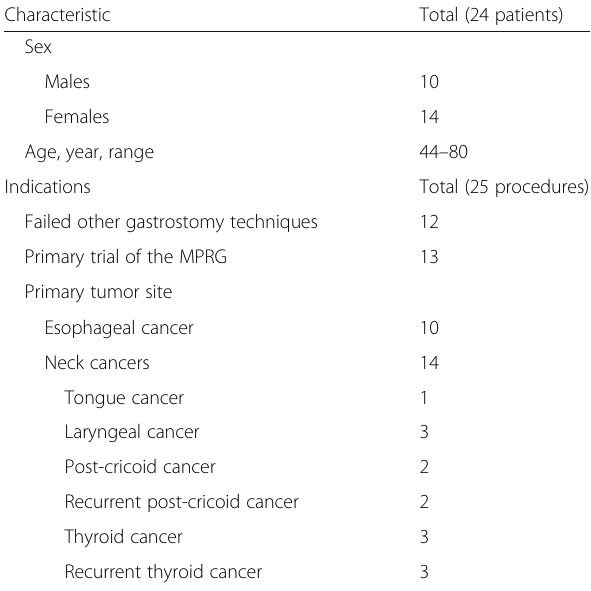
Table 1 Characteristics of 24 patients with upper digestive tract malignant obstruction